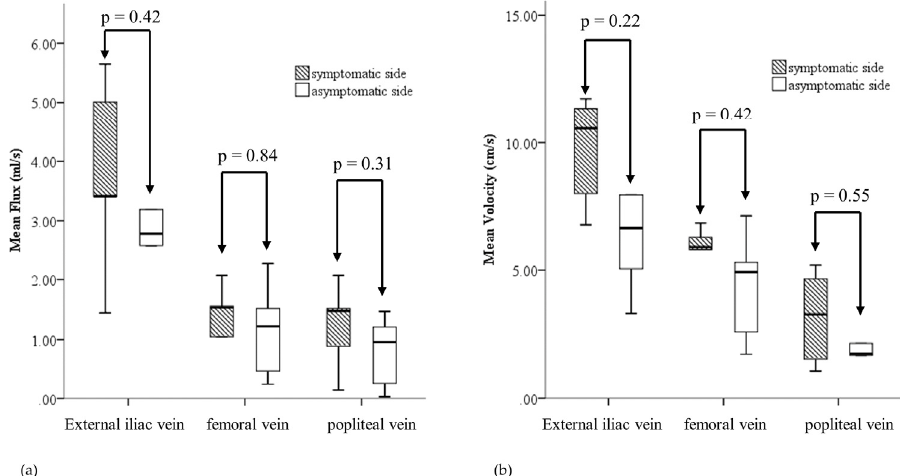
Figure 5. Boxplots comparing mean flux ( a ) and mean velocity ( b ) between the right and left pop- liteal veins, femoral veins, and external iliac veins of the patients with bilateral common iliac venous or inferior vena cava compression.